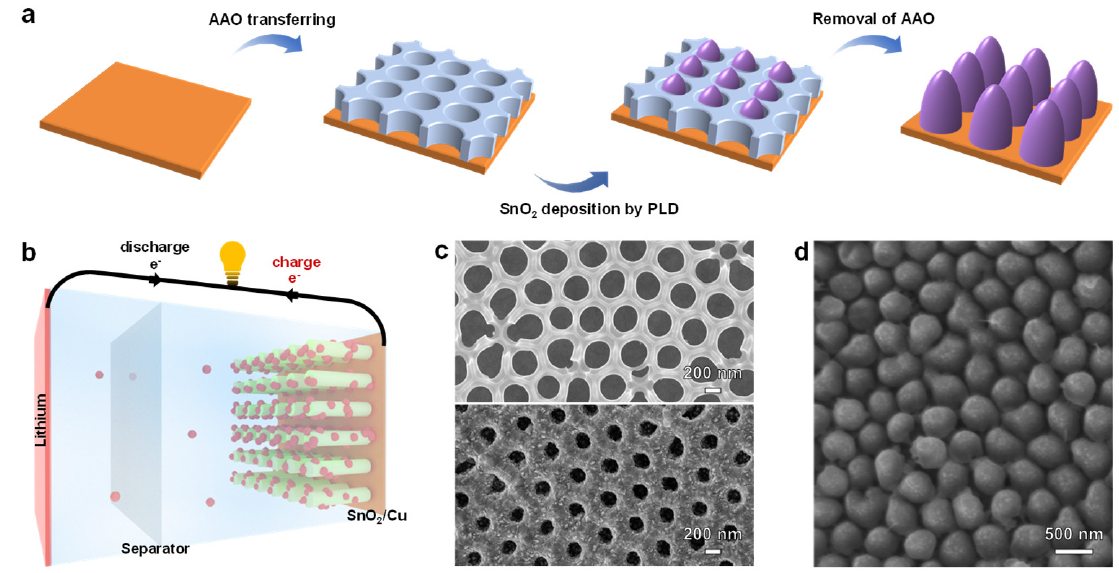
Figure 1. SnO 2 array deposition. ( a ) Fabrication of SnO 2 nanopillar array by PLD using AAO template on a Cu foil substrate; ( b ) Schematic diagram of a half-cell Li-ion battery, where SnO 2 nanoarray is used as an anode and Li-foil is used as a cathode and counter electrode; ( c ) SEM images of bare AAO template (upper panel) and AAO template after SnO 2 deposition (lower panel); and ( d ) a top-view SEM image of the SnO 2 nanopillar array after the removal of AAO template.